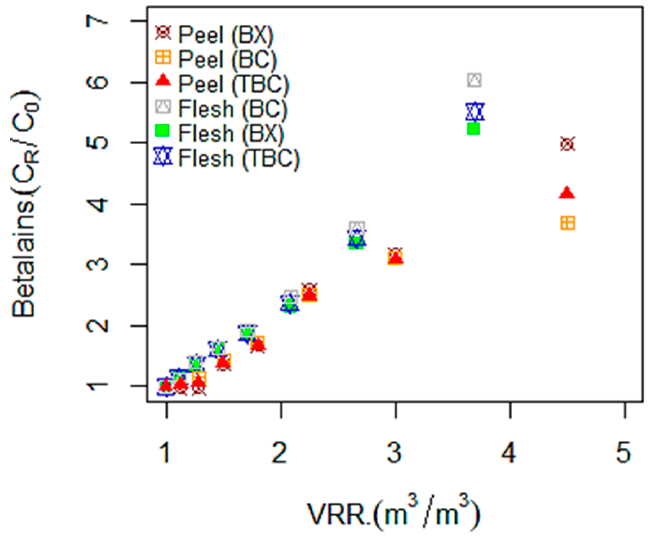
Figure 1. Variation of betalains during the concentration by RO membrane (X20).